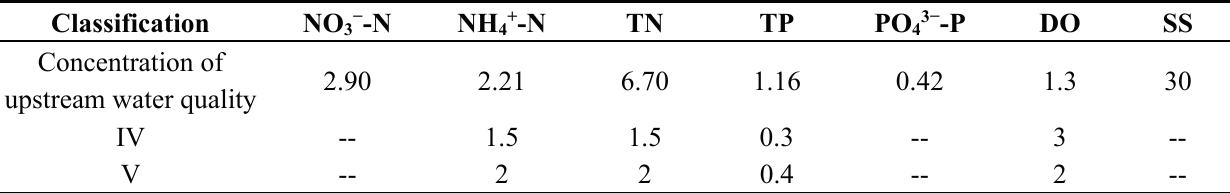
Figure 3. Location of the study area and sampling points in the Tianlai River. Table 2. Comparison between upstream water quality of the Tianlai River and Grade V, IV of the China Standard for Surface Water